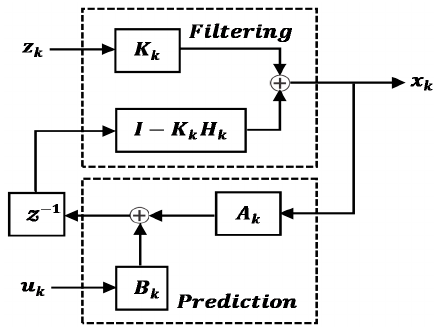
Figure 4. Kalman filter Prediction-Update procedure ( (cid:2314) (cid:2879)(cid:2869) represents a unit time delay).